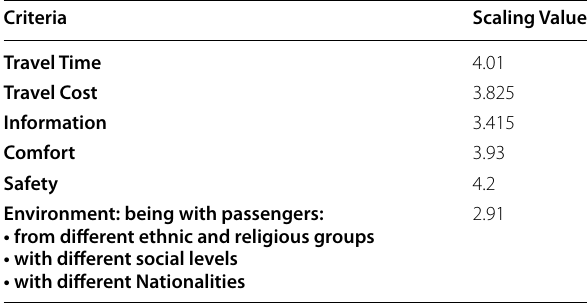
Table 2 Mean weighting values of criteria Criteria